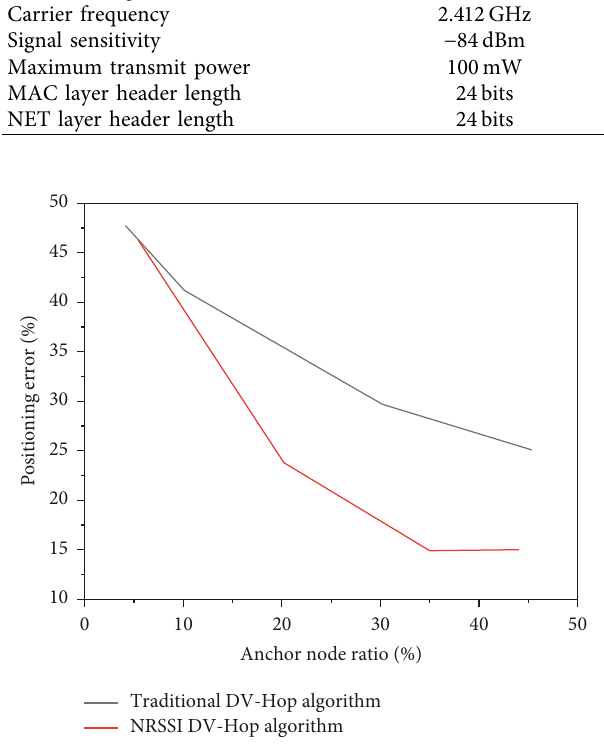
Figure 9: Comparison of location errors of unknown nodes in one hop.